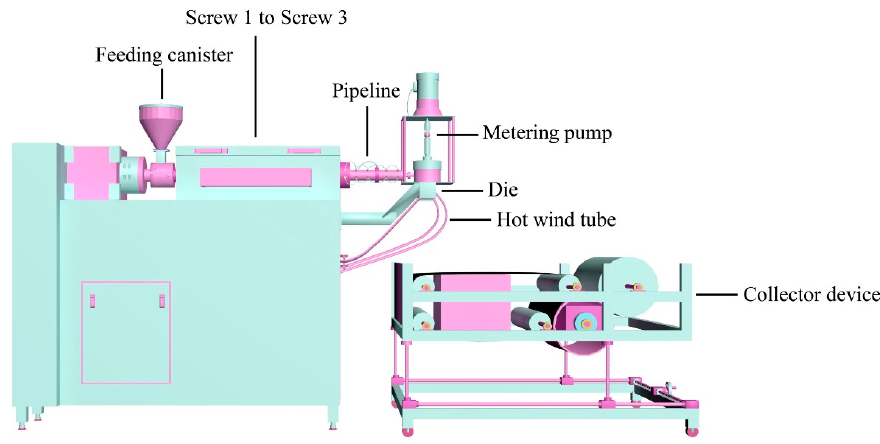
Figure 2. Schematic drawing of the meltblown process. Table 2. Processing conditions of meltblown membranes.